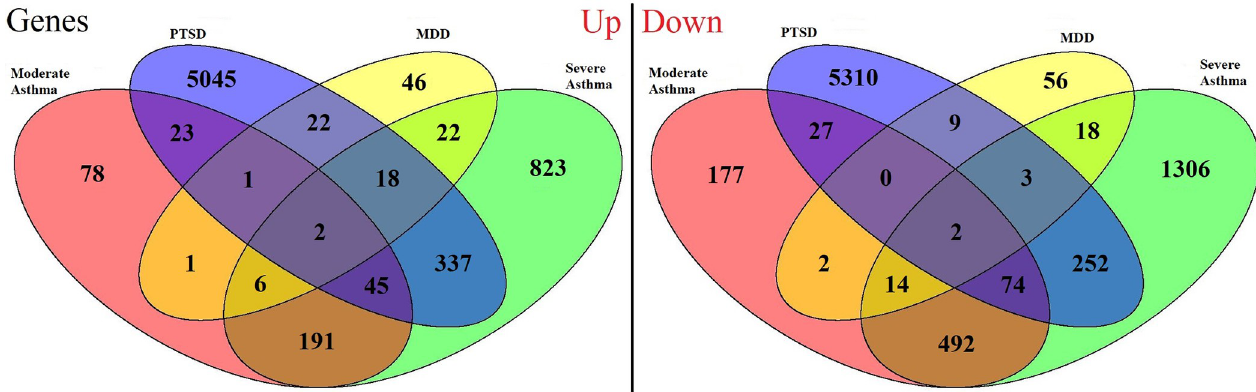
Fig 3. The number of genes differentially expressed from healthy subjects in the same direction between different diseases. The numbers within the different overlaps of the venn diagram are the number of genes significantly (adjusted P-value < 0.05) differentially expressed in both exploration datasets. For example, in the left ‘up’ panel, there are 22 genes in the PTSD and MDD exploration sets that are similarly significantly overexpressed, and in the right ‘down’ panel, there are 2 genes commonly underexpressed in all disease exploration datasets compared to their respective healthy controls.